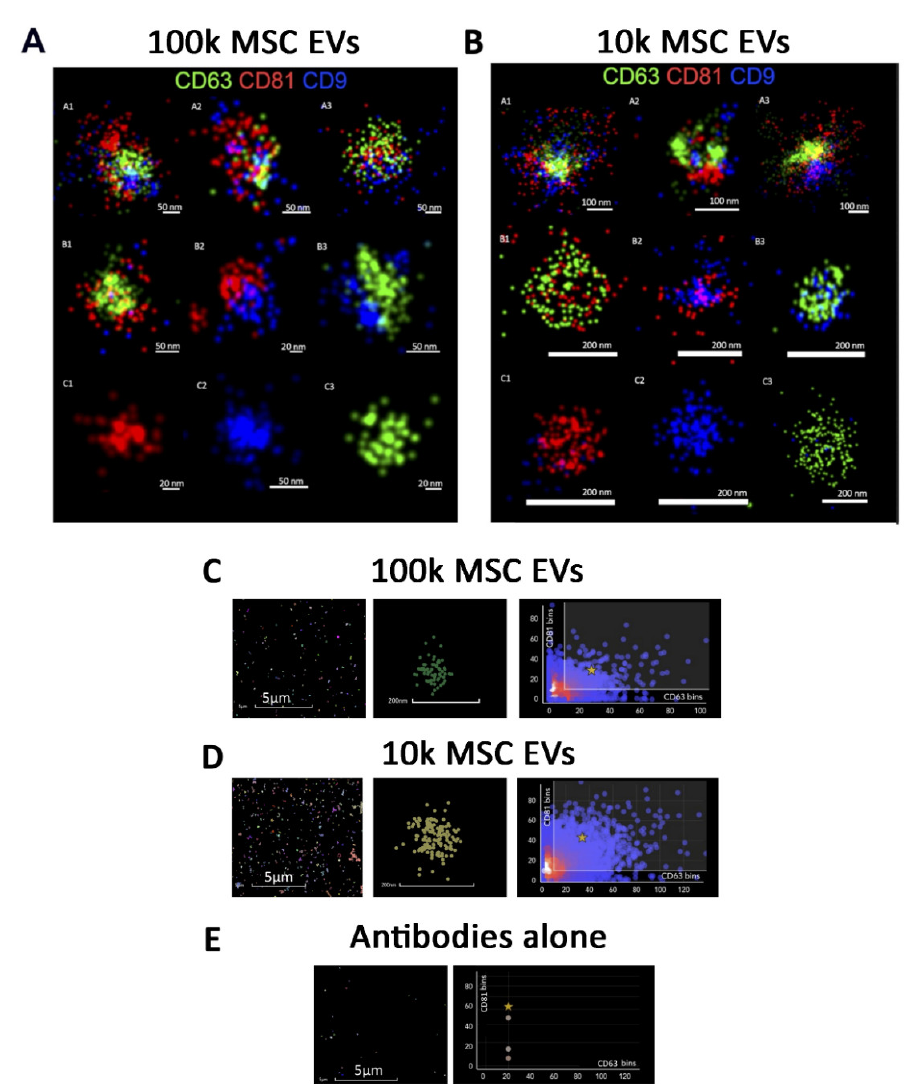
Figure 3. Super-resolution microscopy images. Representative super-resolution microscopy images of 100k EVs ( A ) and 10k EVs ( B ) stained with tetraspanins: CD81 red, CD63 green, and CD9 blue. Both panels ( A , B ) show triple positive, double positive and single positive MSC EVs. The corresponding scale bare is below each EV image. ( C ) Representative clustering strategy of MSC 100k EVs with large field of view (left panel), a selected cluster (central panel) and graph (right panel) showing CD81/CD63 cluster distribution. ( D ) Representative clustering strategy of MSC 10k EVs with large field of view (left panel), a selected cluster (central panel) and graph (right panel) showing the proportion of CD81 and CD63 antibodies/cluster. ( E ) Representative clustering strategy of negative control using antibodies alone without EVs showing large field of view and graph demonstrating the proportion of CD81 and CD63 antibodies.